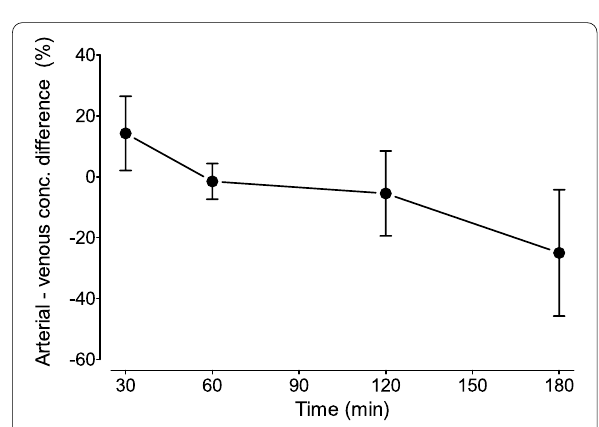
Fig. 2 The arterial‑venous difference in radioligand radioactivity concentrations (mean SD) in four healthy ±